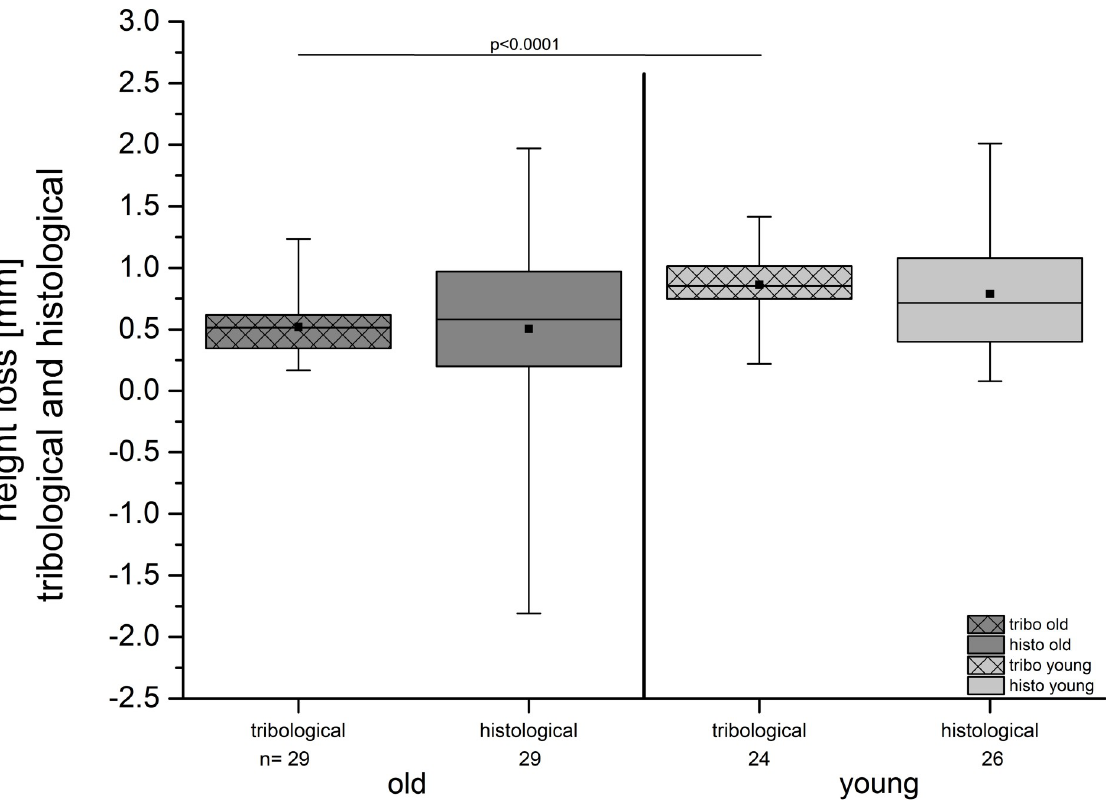
Fig 8. HL of the pair—specimens after tribological exposure was noticed in both groups (old and young); this was confirmed by the histological measurements. The HL was pronounced in the young cartilage specimens in comparison with the old cartilage. This result was significant in the tribological measurements. The histologically determined difference was not significant (p = 0.133).